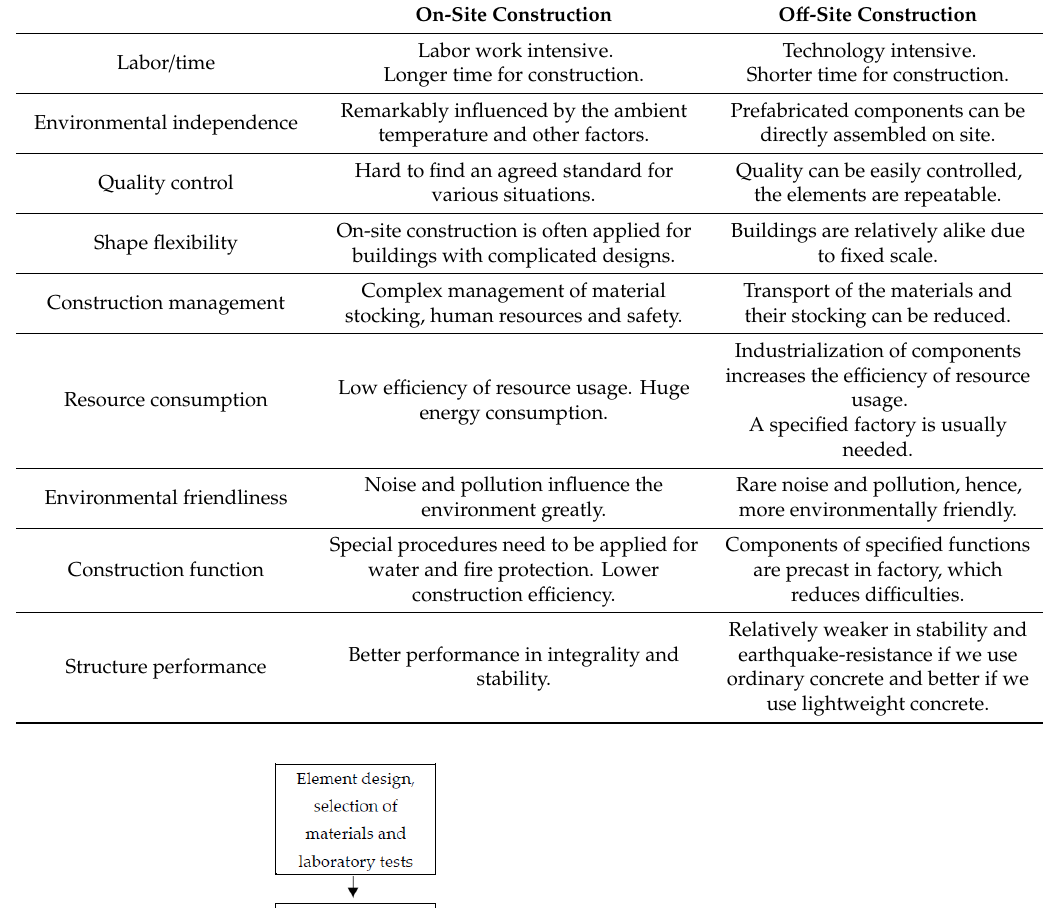
Table 1. Comparison between on-site and o ff -site construction based on [26].